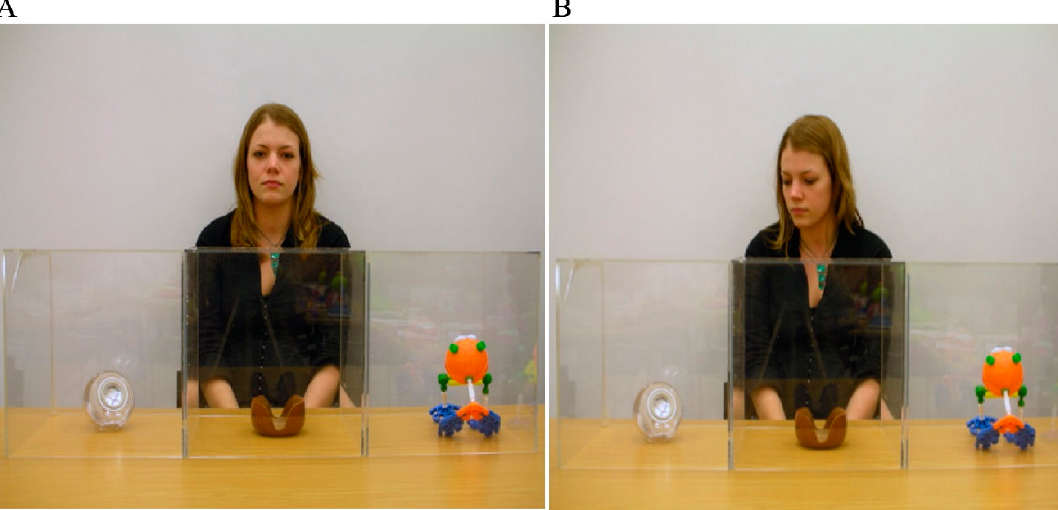
Figure 1. Example of the word learning paradigm used by Norbury et al [11]. Reproduced with permission from Elsevier. Image ( A ) is an example of the gaze neutral condition and image ( B ) is an example of the gaze bias condition.